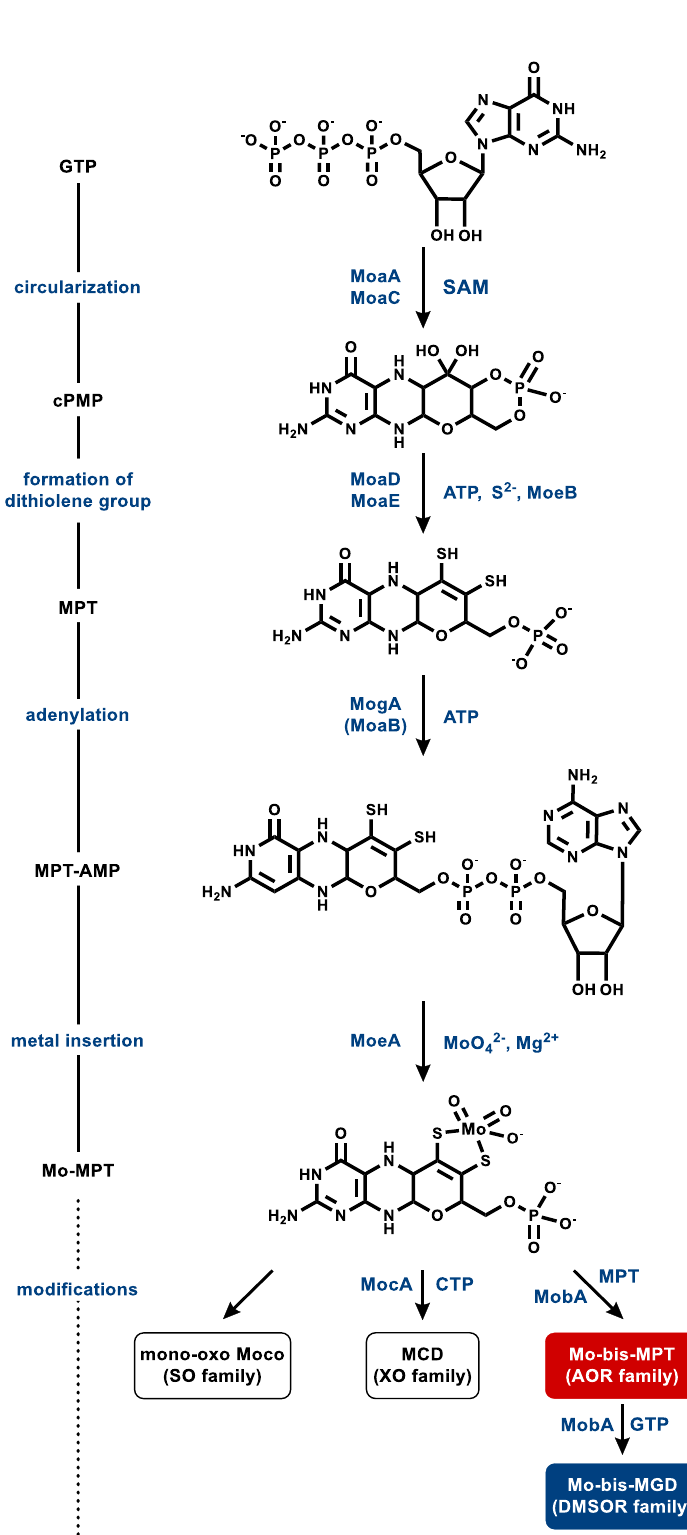
Figure 8. Moco biosynthesis in E. coli . In prokaryotes, the steps from GTP to MPT-adenosine monophosphate (AMP) are catalyzed by similar enzymes for Moco and Wco synthesis. YdhV from E. coli is the only characterized molybdenum-containing AOR family member [126].